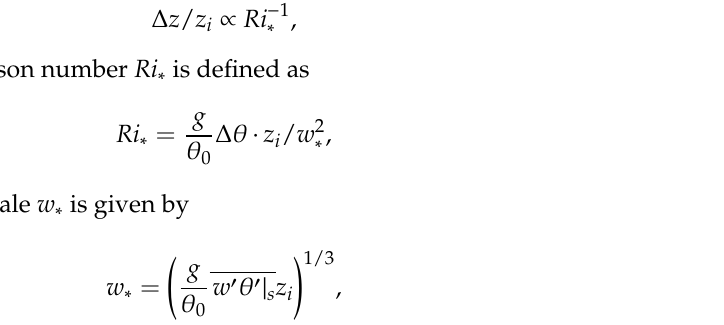
Figure 1. The schematic description of a convective boundary layer (CBL). ( a ) A snapshot of the thermal distribution obtained from numerical simulation and ( b ) the vertical profiles of the potential temperature θ and buoyancy flux w (cid:48) θ (cid:48) . The dashed lines represent the actual horizontally averaged profiles, and the solid lines represent their counterparts in the first-order model (FOM). ∆ θ , ∆ z , Γ θ and w (cid:48) θ (cid:48) | s are the potential temperature jump across the entrainment zone, the entrainment zone thickness, the gradient of the potential temperature in the free atmosphere layer, and the surface buoyancy flux, respectively. w is the vertical velocity component. The overbars denote the horizontal averages, and the primes represent the deviations from the horizontal averages.